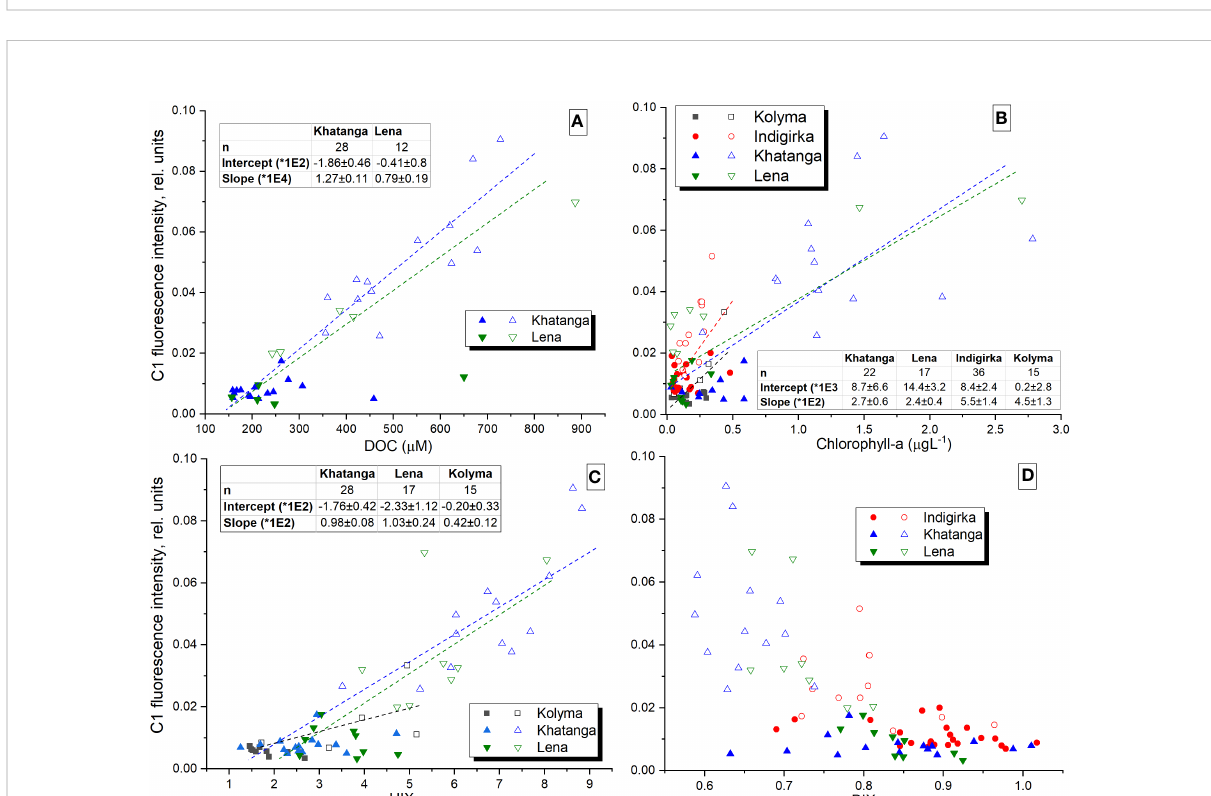
FIGURE 10 Fluorescence intensity of C1 against DOC, chlorophyll-a, HIX, and BIX. Filled symbols indicate the data obtained outside the river plume regions with salinity above